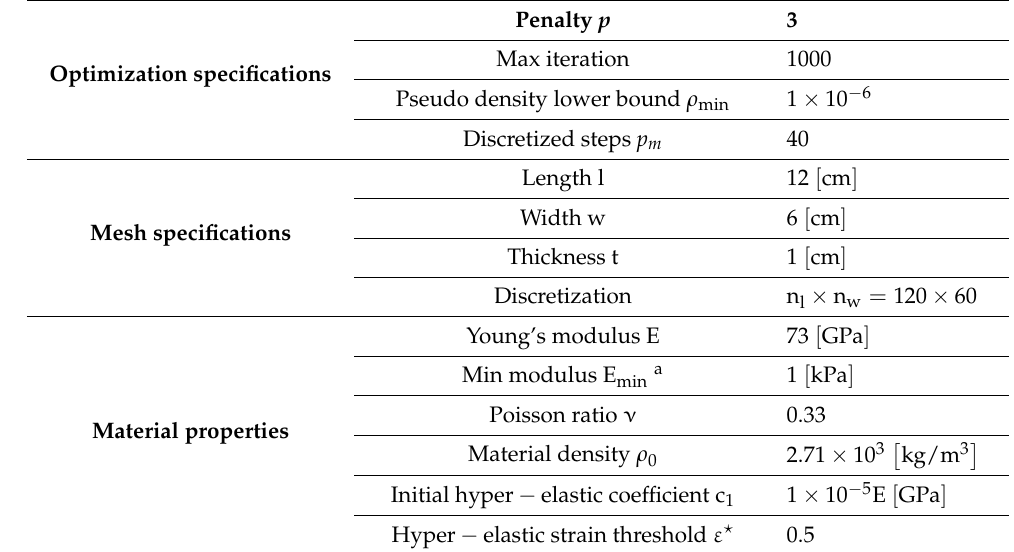
Table 3. Algorithm and material specifications for the TO method.